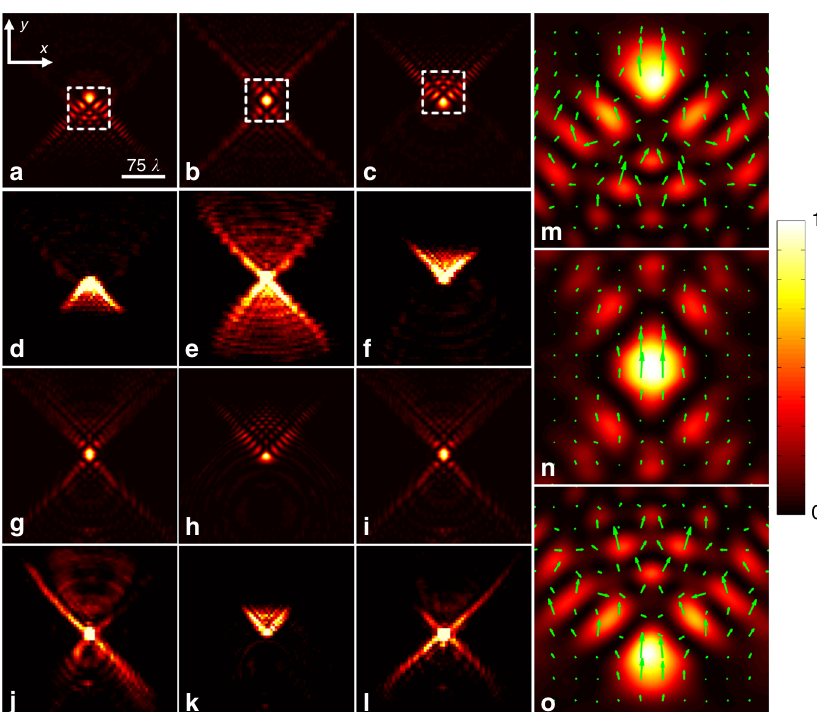
Fig. 3 Light intensities of UAD light beams in different z planes. a – c , g – i and d – f , j – l are the theoretical and experimental results, respectively, where a , d z = − 1100 λ ; b , e z = 0; c , f z = 1100 λ ; g , j z = − 1465 λ ; h , k z = 0, and i , l z = 1465 λ . All are denoted by the points a-f and A-F in Fig. 2. Points B, D, F and b, d, f are the theoretical and experimental switch points, respectively. m – o are the energy fl uxes of a – c , which are indicated by the green arrows. All light intensities are normalized to a unit value, which are indicated by the color